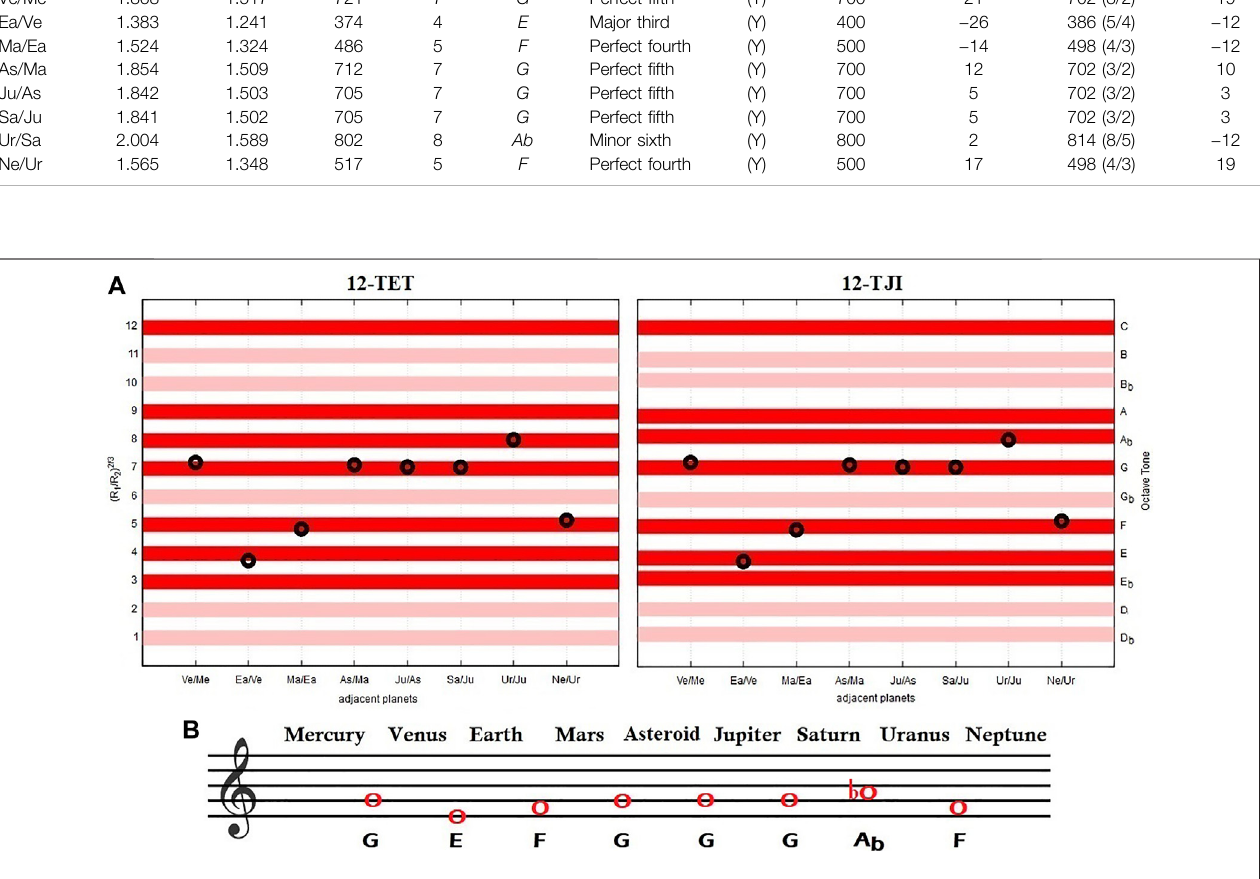
FIGURE3|(A) :Theblackcirclesindicatethedistanceratiosraisedtothe2/3rdspowerofadjacentplanetsinboththeequaltempered12-TETandjustlytuned12- TJI (in the key of C expressed as half-steps or MC/100): Table 4 . The red bars indicate the consonances, while the pink ones the dissonances. The width of each bar